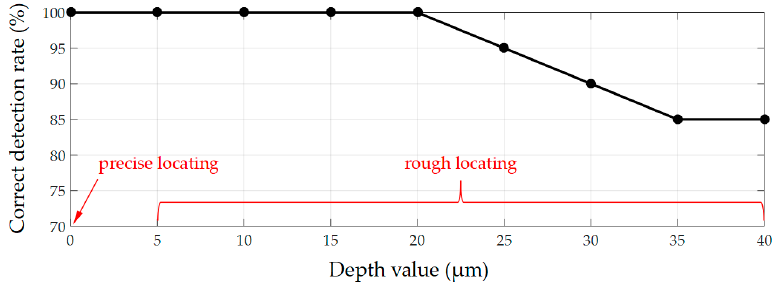
Figure 9. Correct detection rate of planar locating.